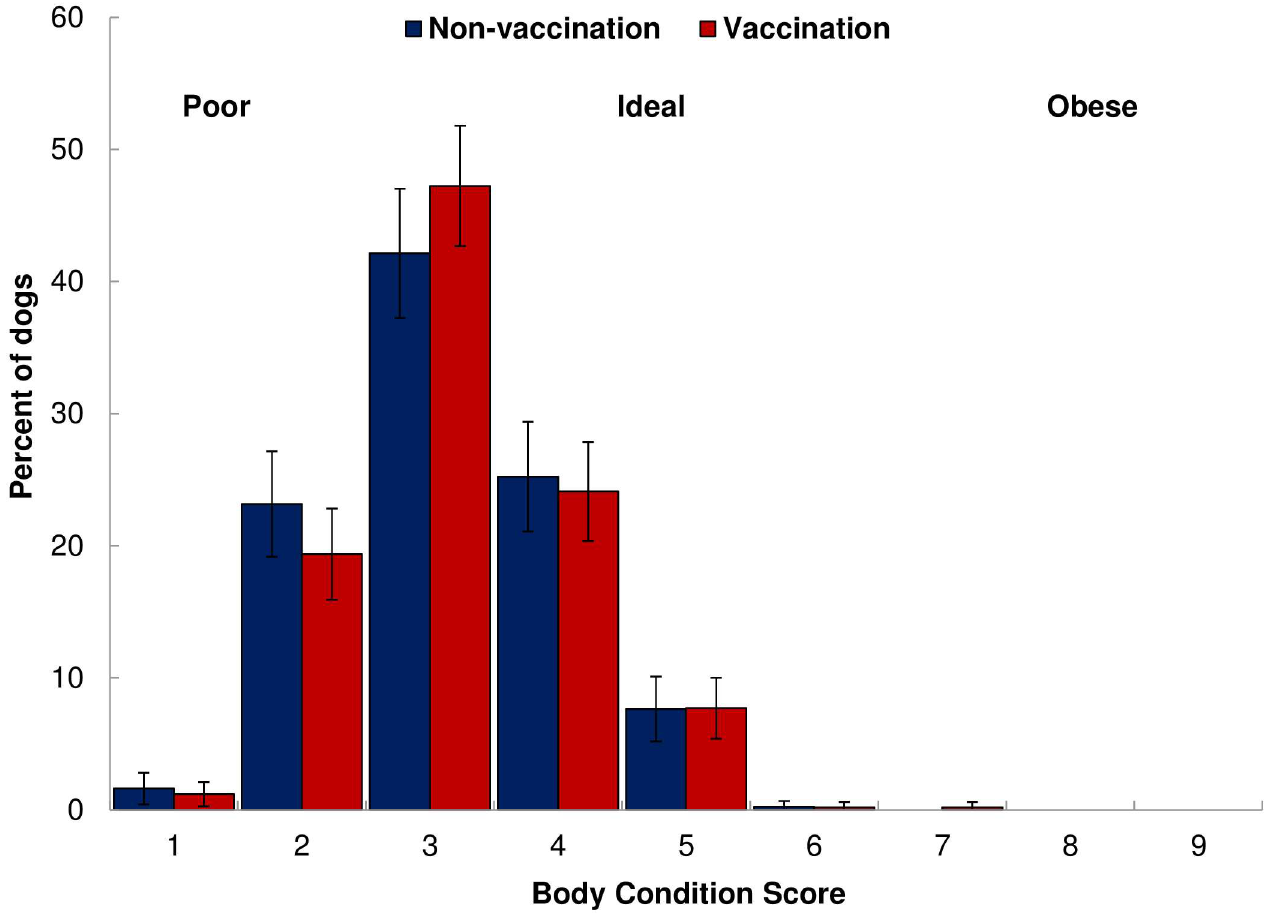
Fig 5. Percentage of body condition scores (BCS) of dogs alive in 2013. Blue bars represent non-vaccination villages(Buyubi and Iyogelo). Red bars represent vaccination villages (Nangale and Sanungu).Body conditionwas scored as 1–2 = poor; 5 = ideal; 8–9 = obese. We did not observeany obesedogs throughoutthe study. Error bars indicate95%